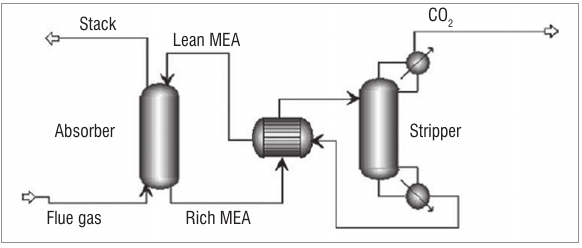
A typical solvent absorption process using mono-ethanola- mine (MEA). 2